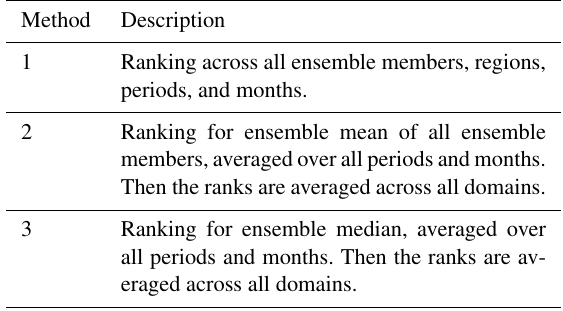
Table 1. Description of the ranking